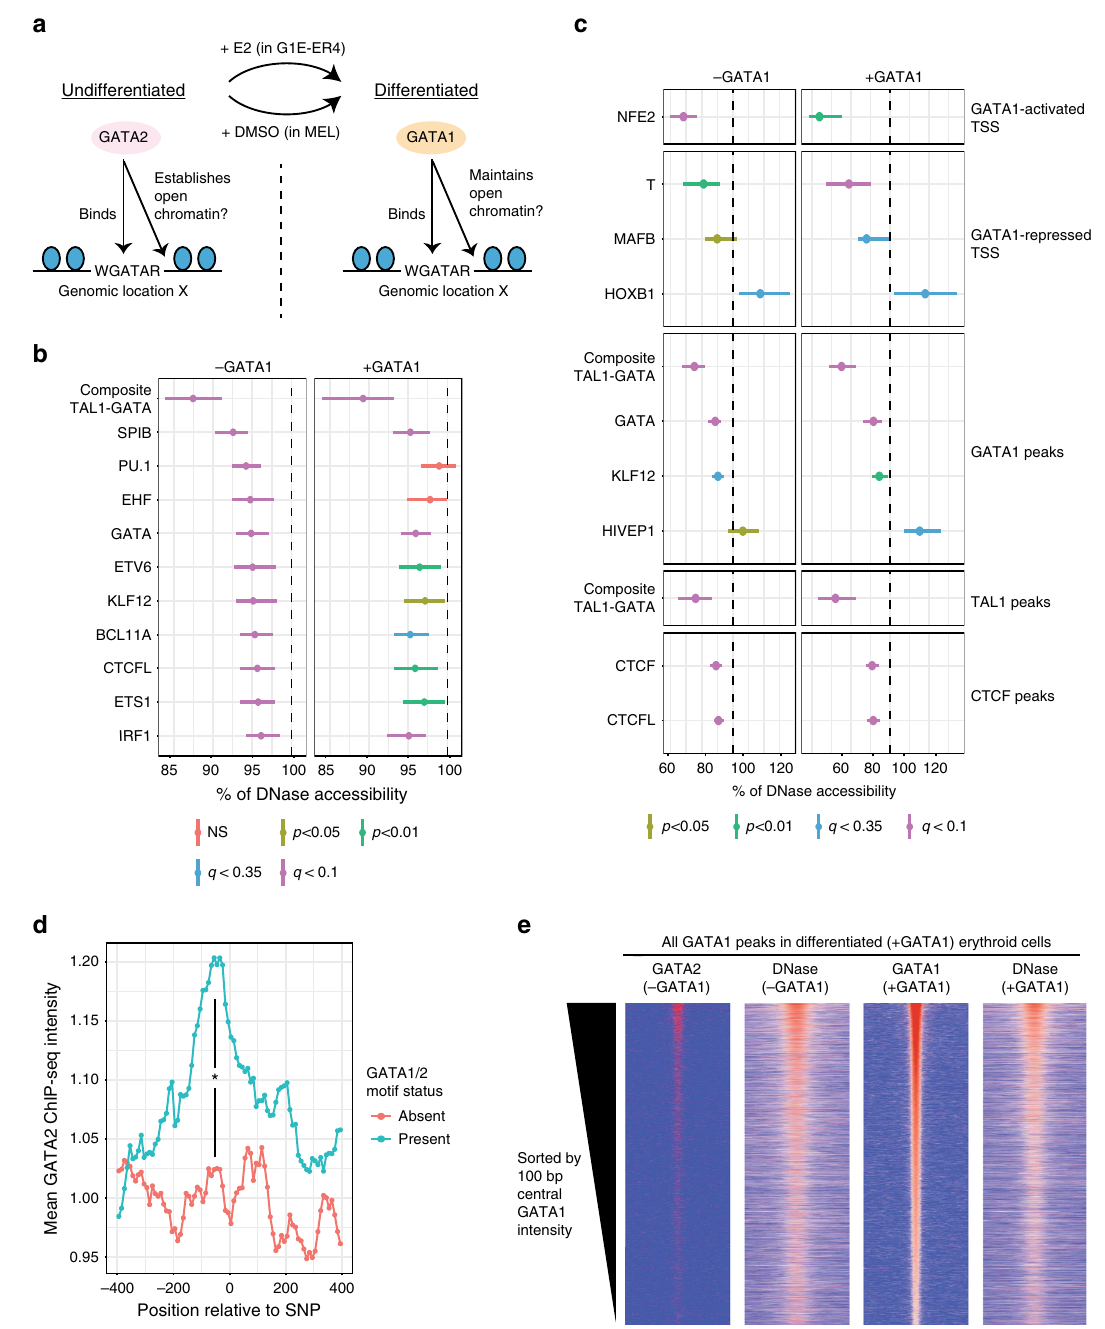
Fig. 6 Genetic variation identi fi es DNA motifs that promote accessible chromatin at TF binding sites. a Model describing the undifferentiated GATA2 high GATA1 low and the differentiated GATA2 low GATA1 high erythroid states and the roles these TFs may play in regulating chromatin accessibility. b TFs whose motifs signi fi cantly alter genome-wide DNase peak signal (% impact, median ± 95% CI) when disrupted by a discSNP in undifferentiated ( − GATA1) or differentiated (+GATA1) erythroid cells. Vertical line indicates no effect, and color indicates signi fi cance level. c TFs whose motifs signi fi cantly alter DNase signal (% impact, median ± 95% CI) at GATA1-regulated promoters or within TF binding peaks when disrupted by a discSNP in undifferentiated ( − GATA1) or differentiated (+GATA1) erythroid cells. d Mean ChIP-seq intensity of GATA2 (in undifferentiated erythroid cells) at DNase peaks bound by GATA1 (in differentiated cells) at either an intact GATA motif or at one disrupted by a discSNP. Position is shown relative to the discSNP position ( − 400 bp upstream to 400 bp downstream). Signi fi cant differential binding (*) was assessed by BH-corrected Wilcoxon's test in the − 200 to +200 region ( q = 0.003). e Heatmaps showing the intensity of either GATA2 or GATA1 binding or DNase hypersensitivity in the undifferentiated ( − GATA1) or differentiated (+GATA1) state at all sites that GATA1 binds in differentiated cells. Peaks (15,527) were sorted by GATA1 binding intensity in the differentiated state, regions span − 1 kb to +1 kb centered on